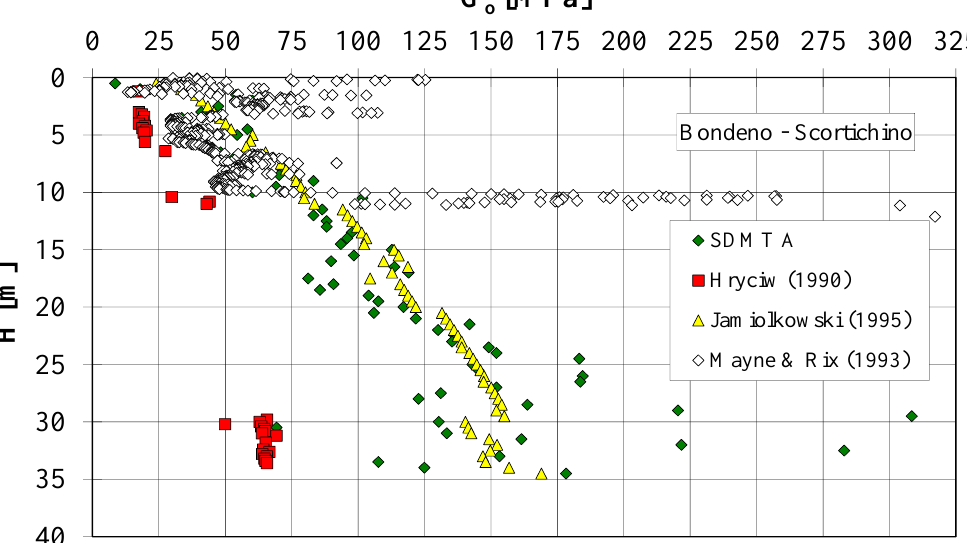
Figure 7. G o from different empirical correlations. 241